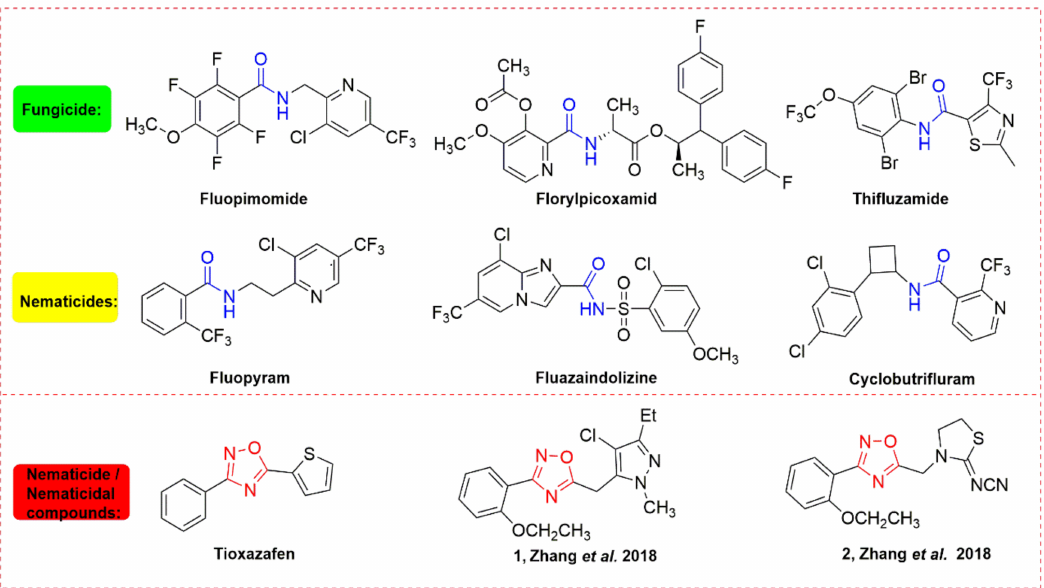
Figure 1. Structures of reported antifungal and nematicidal compounds containing amide or 1,2,4- oxadiazole fragments, compounds 1 and 2 are from Zhang et al.,